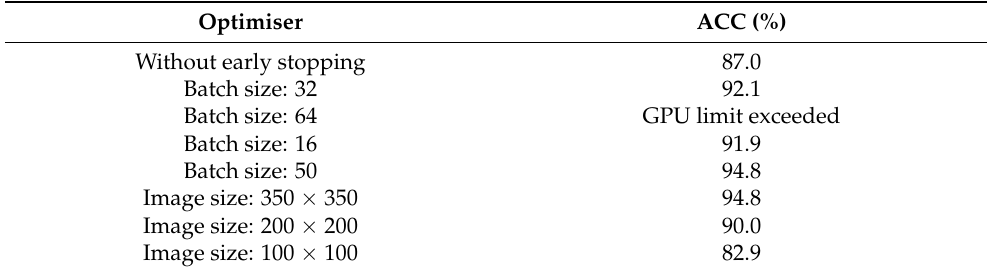
Table 7. The accuracy of ParaNet variations in distinguishing between normal and abnormal scans when altering the total number of trainable convolutional